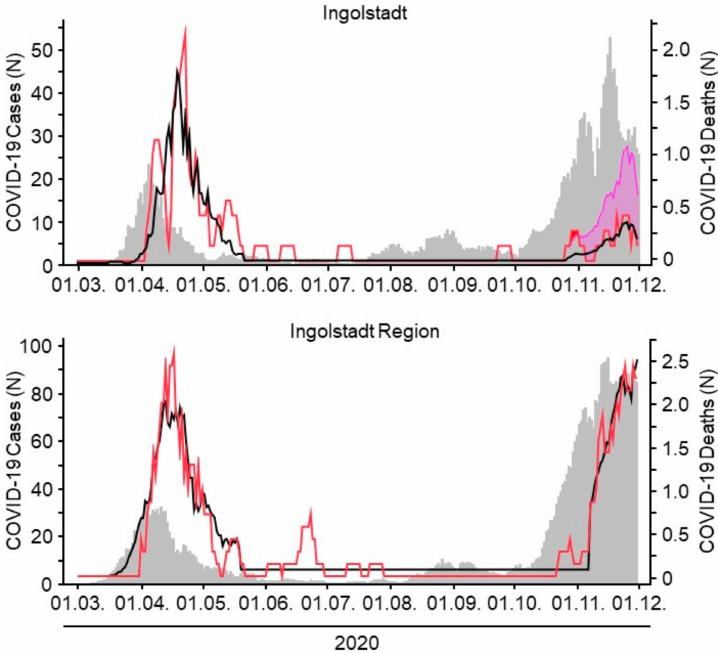
Figure 4. Infection rates (grey curves, left scale) as well as actual case-fatality rates (CFR) (red curve, right scale) and calculated predicted CFRs (black curve, right scale) of COVID-19 for the city of Ingolstadt and the adjacent regional districts (Region) are shown. The case-fatality rate in Ingolstadt during the second wave is significantly lower than in the adjacent Region. The pink curve shows the hypothetical current CFR for Ingolstadt when applying the CFR of the Region, showing that differences in COVID-19 deaths between neighboring regions can be a matter of